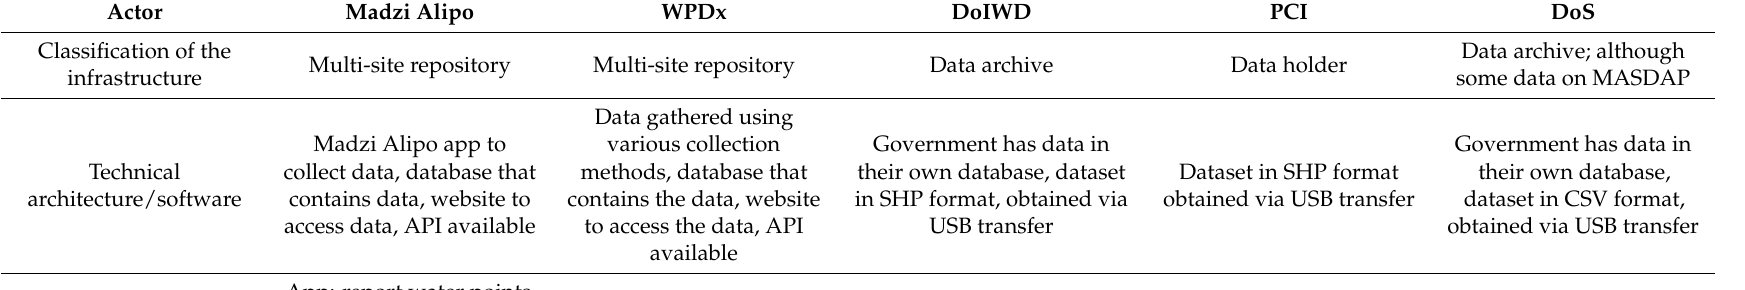
Table 6. Data infrastructure dimension of the data sets of the main actors in the WASH data